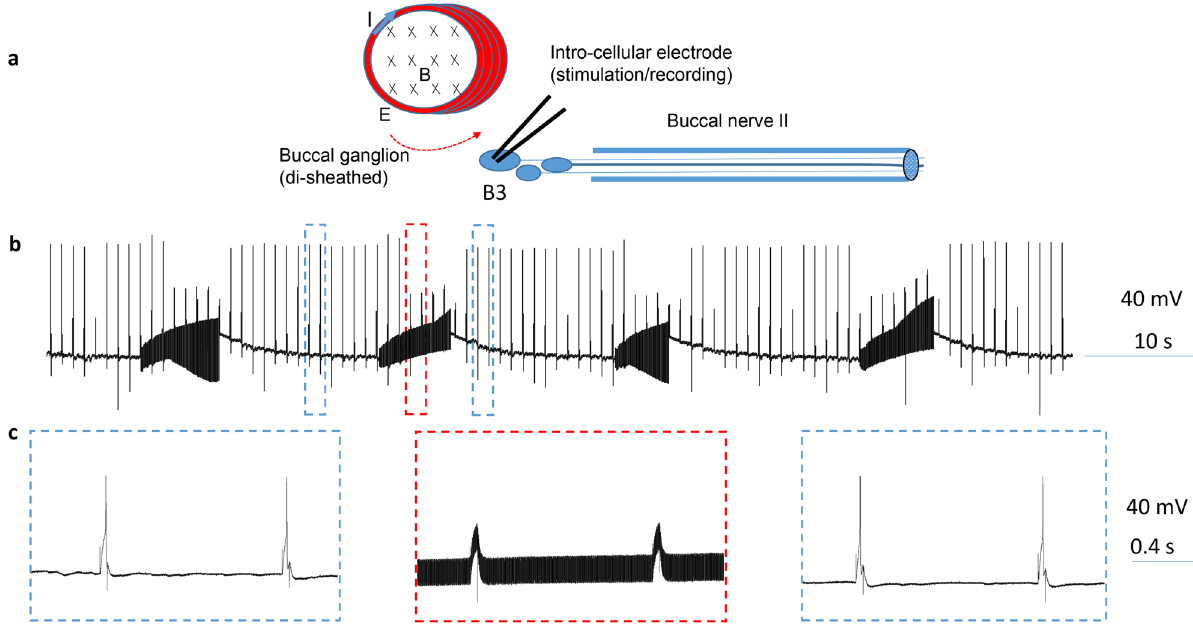
Figure 3. High-frequency magnetic stimulation inhibited buccal ganglion neurons firing at a low rate. ( a ) Experimental setup for the magnetic stimulation of the buccal neurons. The buccal ganglion was de-sheathed. An intracellular electrode was inserted into the B3 motor neuron for stimulation and recording. A miniature coil was positioned on top of the buccal ganglion for magnetic stimulation. I: electric current flow inside the coil. X: direction of the magnetic field generated by the coil current. Red arrow indicates the induced electric field by the coil. ( b ) Single action potentials were generated at 1 Hz by 4 ms current pulses delivered to the B3 soma. Coil stimulation reversibly suppressed these action potentials. ( c ) Expanded traces in ( b ).